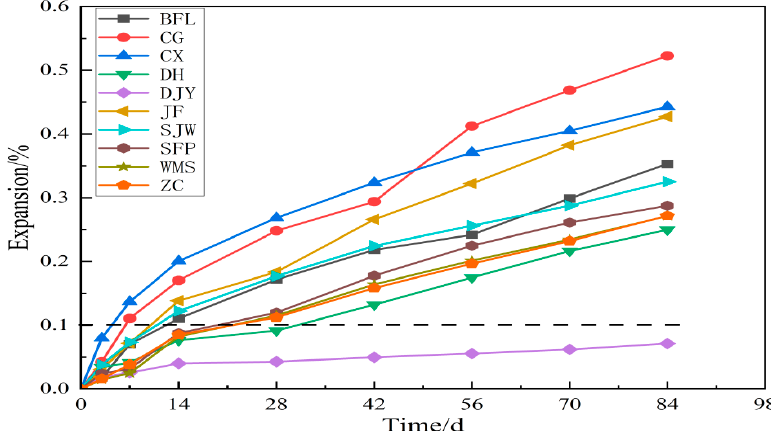
Figure 5. The expansion of the concrete microbars prepared according to RILEM